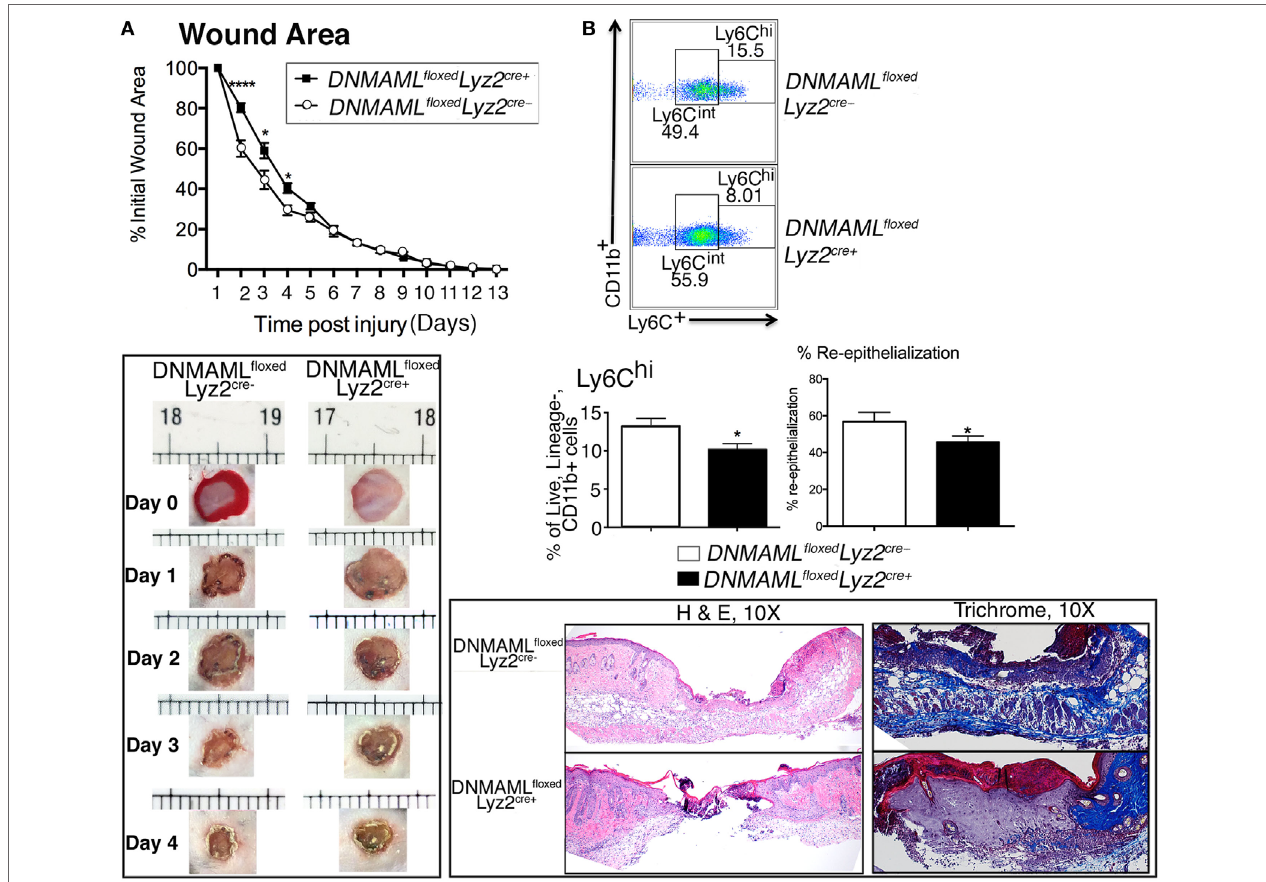
FigUre 3 | genetic blockade of canonical notch signaling in macrophages results in decreased inflammatory wound macrophages and delayed early wound healing . Wounds were created using 4 mm punch biopsies on the backs of DNMAML floxed Lyz2 Cre + and littermate control mice. (a) Change in wound area was recorded daily using ImageJ Software (NIH) until complete healing was observed. Data are pooled from two experiments ( n = 20 wounds in 10 mice/ group, repeated 3 × ) (* P < 0.05; **** P < 0.0001). Histopathology (H&E) and collagen deposition of wounds of DNMAML floxed Lyz2 Cre + and littermate controls on post-injury day 4. DNMAML floxed Lyz2 Cre + wounds showed less reepithelialization, granulation formation, and collagen deposition. Data are pooled from two experiments ( n = 20 wounds in 10 mice/group, repeated 2 × ). (B) Analytical flow cytometry of Lin − /Ly6G − /CD11b + /Ly6C hi wound cells in from DNMAML floxed Lyz2 Cre + mice and littermate controls at day 3 post-injury ( n = 10 wounds in 5 mice/group, repeated 2 × ) (* P < 0.05). Statistical analysis was performed using two-tailed Student’s t -test. All data are expressed as mean ±